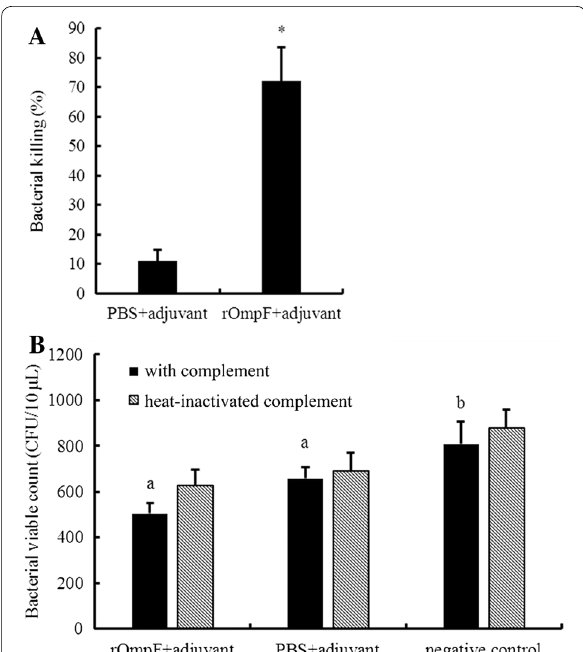
Fig. 5 Phagocytosis and bactericidal activity of the macrophages modulated by the anti-rOmpF sera in vitro. A Effect of the anti-rOmpF sera on opsonophagocylic killing of E. coli by murine macrophages. Data are expressed as percentage (mean SD) of killed bacteria; Fig. 6 Protection efficacy after immunization with rOmpF against E. ± B bactericidal activity of serum complement on E. coli . Escherichia coli CVCC 1515 and CICC 21530 (O157:H7) in vivo. After 2 weeks of coli CVCC 1515 was incubated for 1 h with the anti-rOmpF sera and the final immunization, the mice were challenged with E. coli CVCC complement (or heat-inactivated complement) (the rOmpF adju- 1515 by intraperitoneal injection ( A ) or E. coli CICC 21530 (O157:H7) + vant group), the anti-PBS sera and complement (or heat-inactivated by gastric tube ( B ), and observed for 7 days after challenge. Data are complement) (the PBS adjuvant group), and PBS and complement expressed as mean SD. A The survival ratio of the mice immunized + ± (or heat-inactivated complement) (the negative control group), with rOmpF or PBS; rOmpF adjuvant: group 1; PBS adjuvant: + + respectively. Viable bacteria were counted, and data are expressed group 2, control; B fecal shedding of the mice immunized with as mean SD. Lower case letters indicate a significant difference rOmpF or PBS; rOmpF adjuvant: group 3; PBS adjuvant: group 4, ± + + between two groups ( p < 0.05) control. Asterisk indicates a significant difference between two groups ( p <